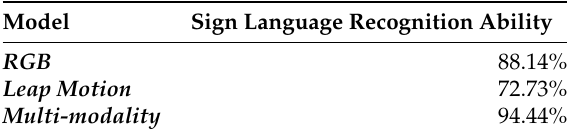
Table 3. Sign Language Recognition scores of the three models trained on the dataset.